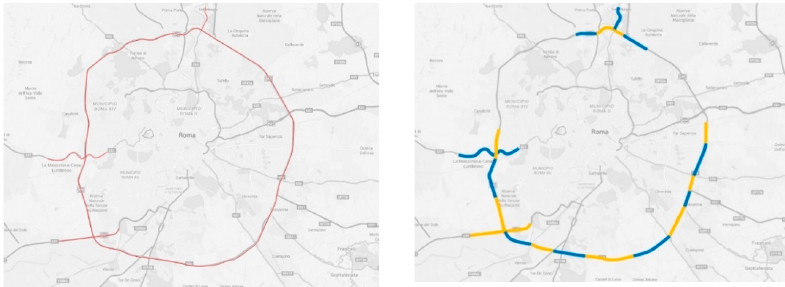
Figure 4. Basic noise maps preparation: split the road network in arcs corresponding to the elementary noise sources.